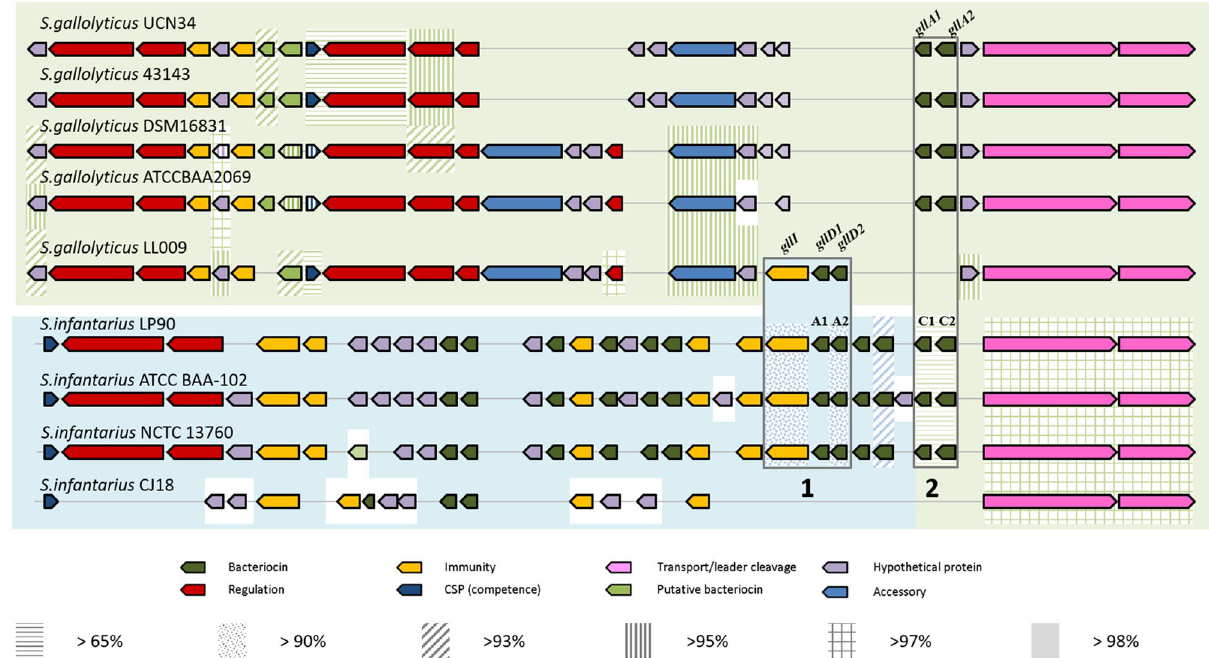
Figure 3. Comparison of the operons of all strains analysed. Genes in line with the same background colour are homologous (> X% amino acid sequence identity indicated), while the white background represents genes for which no homologs have been found between strains; box 1 shows the immunity protein and infantaricin A in S. infantarius strains and immunity protein and the gallocin D variant in S. gallolyticus LL009; box 2 shows potential homologs for gallocin A.